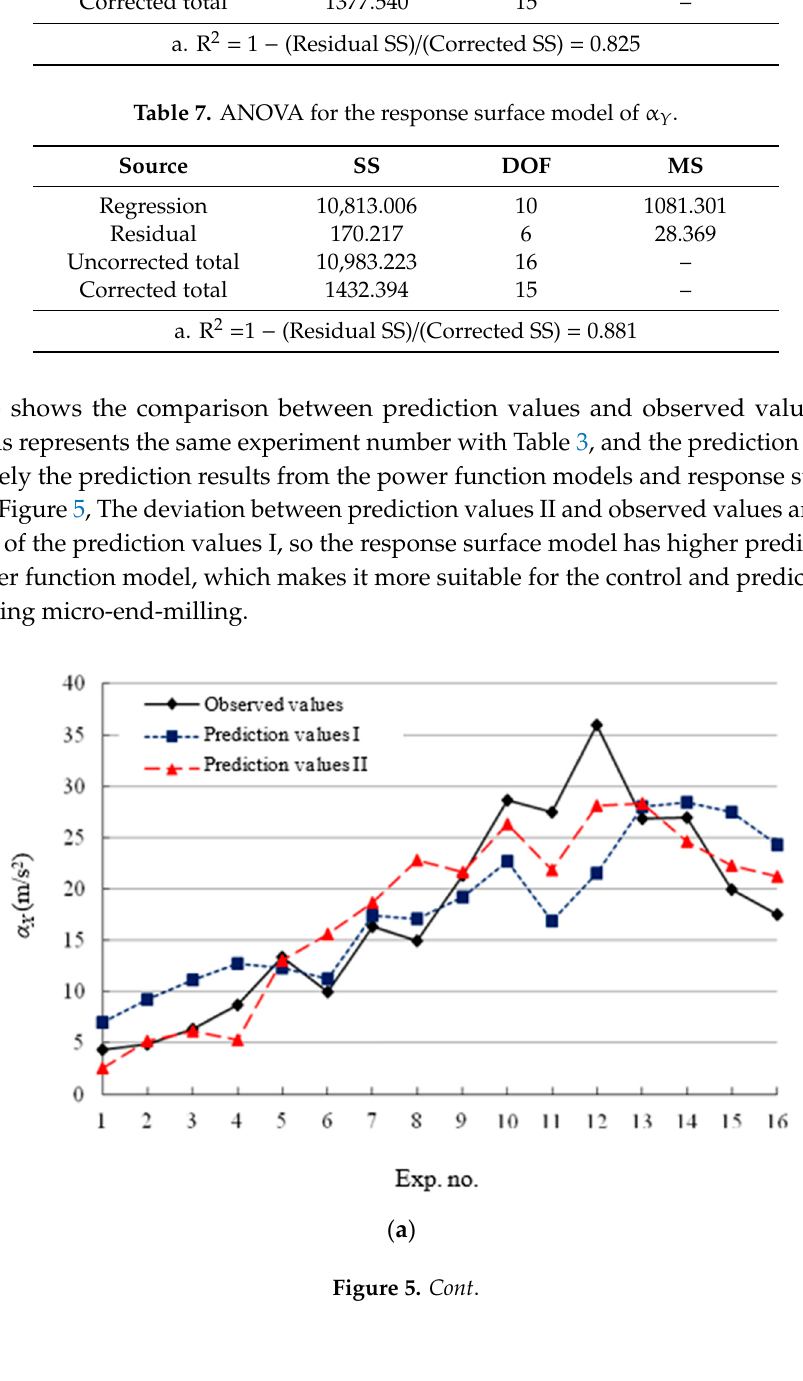
( b ) Figure 5. Comparison between prediction values and observed values. ( a ) feed acceleration vibration α X . ( b ) transverse acceleration vibration α Y.